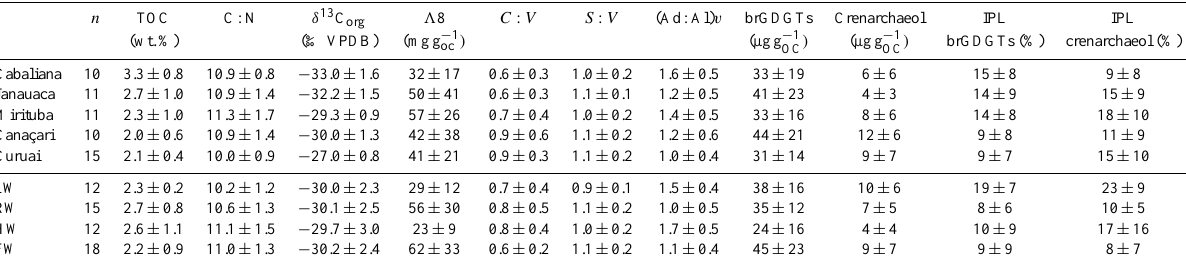
Amazon River 0.5 1.5 Table 3. Average values for the seasonality and spatiality of bulk parameters, lignin phenols and GDGTs in sediment samples from the floodplain lakes. n TOC C : N δ 13 C org (cid:51) 8 C : V S : V (Ad : Al) v brGDGTs Crenarchaeol IPL IPL (wt.%) (µgg − 1 OC